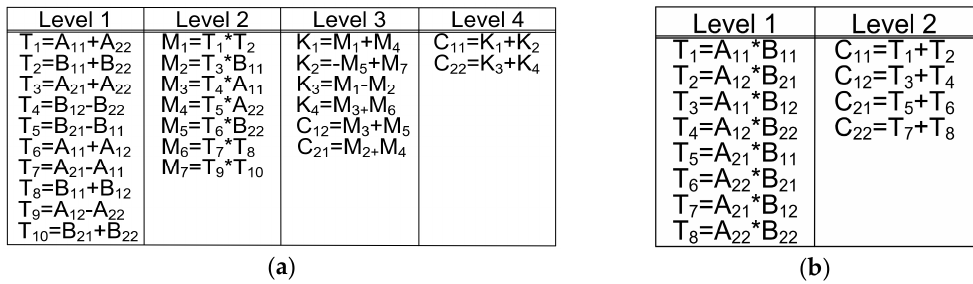
Figure 4. Computational steps of a 2 × 2 matrix multiplication: ( a ) Strassen; ( b )